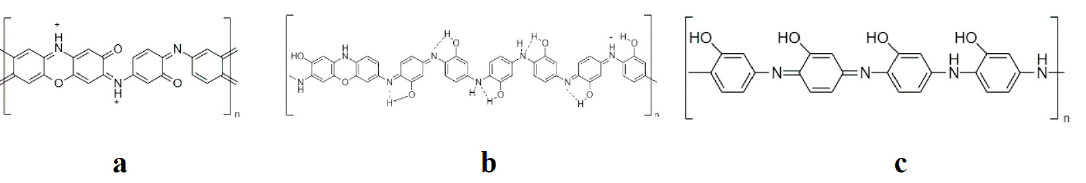
Figure 6. Various PmAP structures: ( a ) open-ring structure. ( b ) complex structure. ( c ) linear structure.